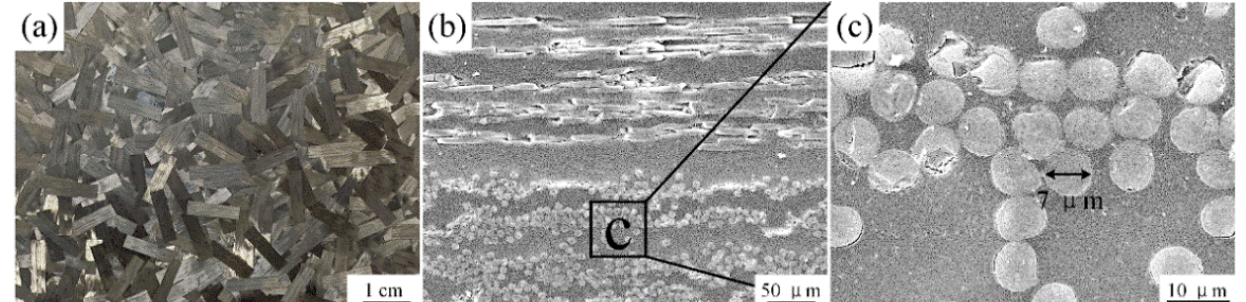
Figure 2. CFRTP chopped sheet: ( a ) macro-structure of the chopped CFRTP sheet from the top view; ( b ) microstructure of the cross-section of the CFRTP chopped sheet; ( c ) carbon fiber diameter.